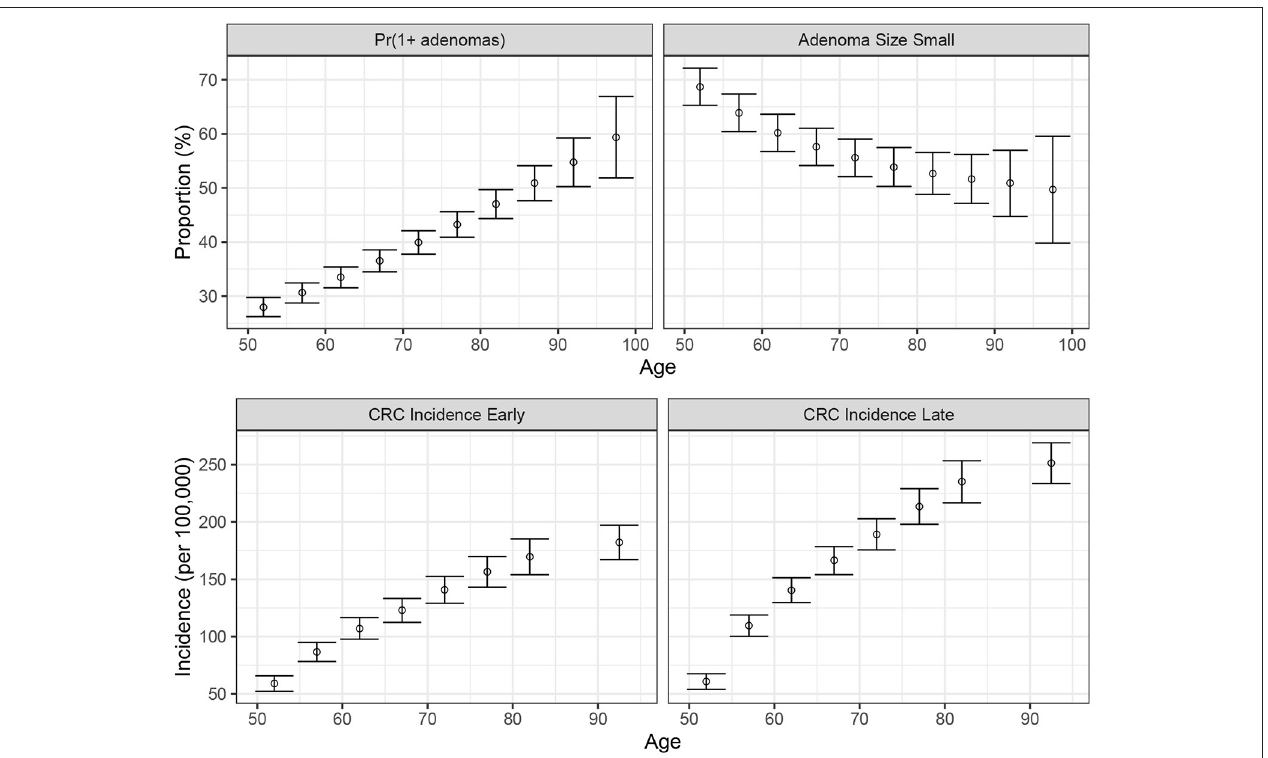
FIGURE 3 | Generated calibration targets and its 95% credible interval of a cohort of 500 and 100,000 simulated individuals for adenoma-related targets cancer incidence targets, respectively plotted against age in years on the x-axis. These distributions are from 100 different runs using the same parameter set values in each set of